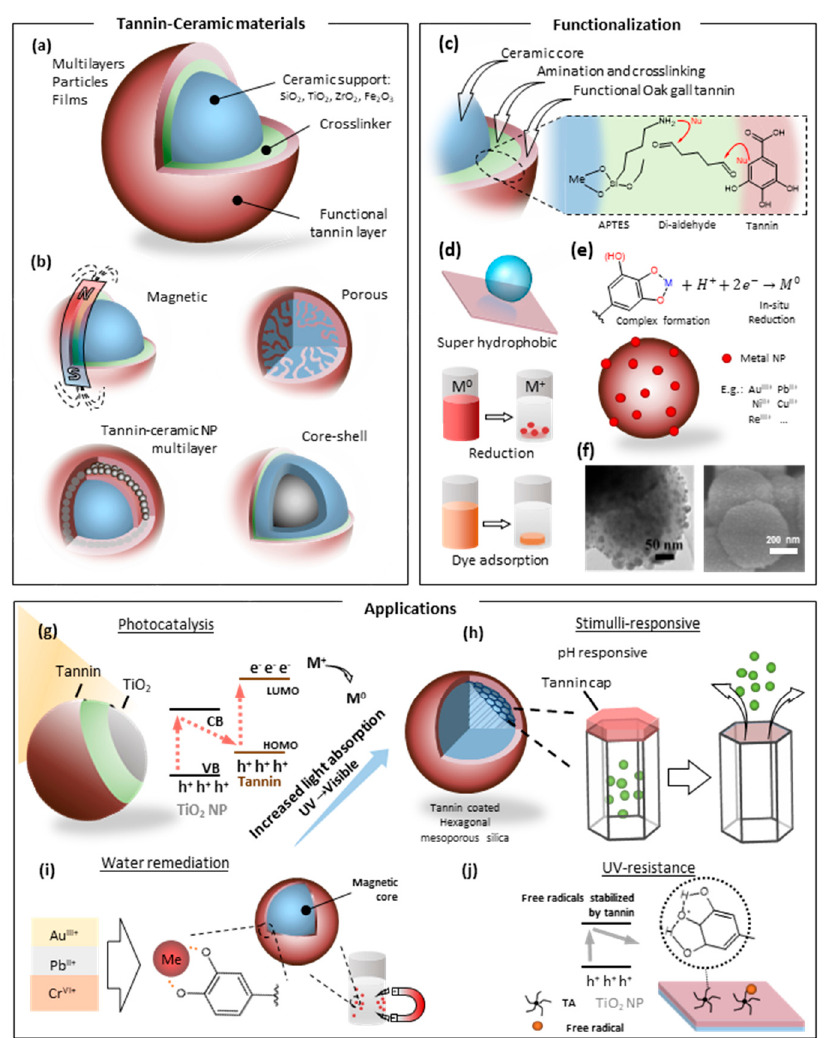
Figure 3 . Overview of tannin–ceramic materials. ( a ) Schematic representation of the typical layout of hybrid tannin–ceramic particles. ( b ) Multiple frequently encountered architectures where the ceramic and tannin parts can have several morphologies and structural arrangements. ( c ) Schematic representation of the ceramic surface functionalization driven by the physicochemical interactions of active groups on the surface of the ceramic core, of the cross-linker and the tannin to form tannin– ceramic hybrids. ( d ) Characteristics and applications of TA-APTES coatings, which are further functionalized with various different reactants, applied to multiple substrates [76]. ( e ) Net reaction on the surface of a tannin-based hybrid material for in-situ metal-ion scavenging and redox reaction to form ceramic–tannin–metal systems shown in ( f ). ( f ) Microstructure of core–shell hybrid particles with deposited metal nanoparticles as the result of in-situ redox reactions. Adapted with permission from Ref. [77]. Copyright 2018 Elsevier Inc. ( g–j ) Schematic representations of example